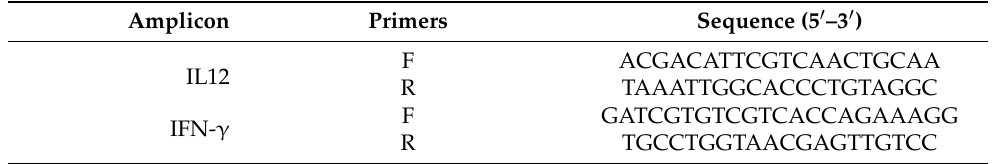
Table 1. Sequences of primers used for real-time